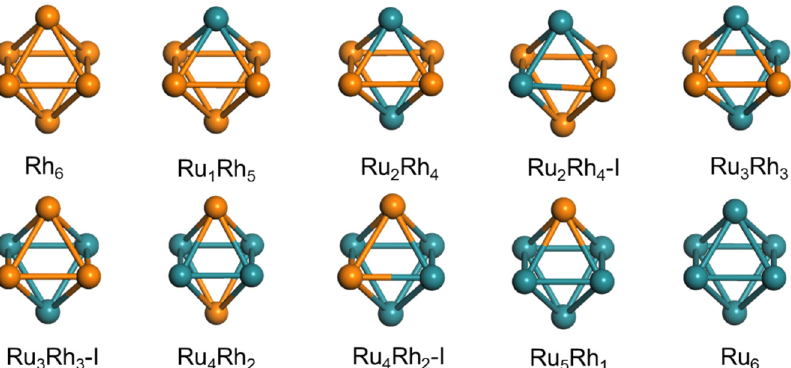
Figure 1. Optimized geometric structure of octahedral Ru m Rh n clusters, green balls represent Ru atoms and orange balls represent Rh atoms. The geometric and energetic parameters for these clusters are reported in Table 1. Ru 4 Rh 2 is a magic cluster. Table 1. Optimized symmetry PG, binding energy E b (eV), bond order σ , and average bond length d (Å) of octahedral Ru m Rh n clusters, including the bond length d (Å) of the Ru-Ru, Ru-Rh, and Rh-Rh. When the atomic number ratio of Ru and Rh is 2:1, 1:1 and 1:2, each proportion corresponds to two structures, represented as Ru 4 Rh 2 and Ru 4 Rh 2 -I, Ru 3 Rh 3 and Ru 3 Rh 3 -I, and Ru 2 Rh 4 and Ru 2 Rh 4 -I.